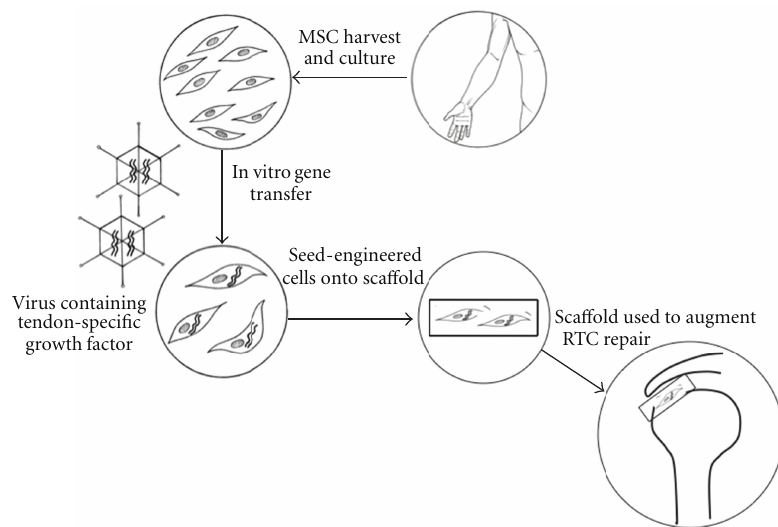
Figure 2: One potential clinical application of stem cell technology for tendon